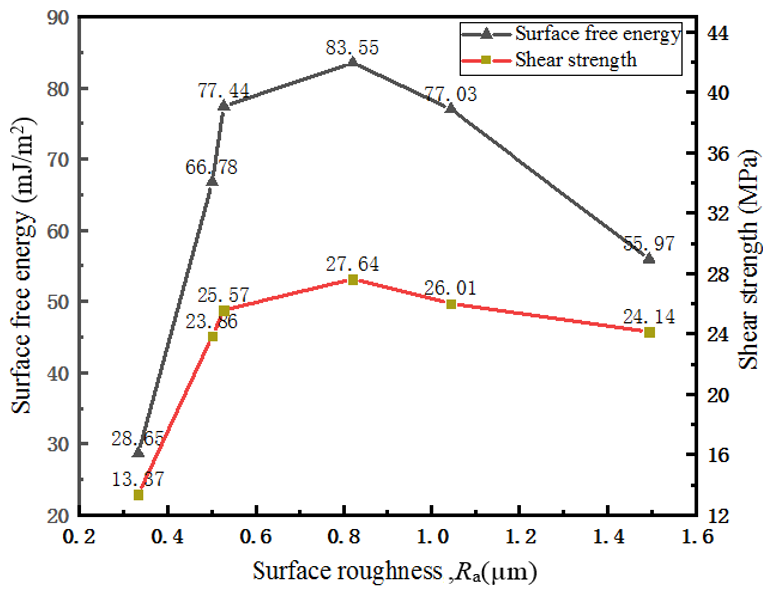
Figure 9. The relationships between R a, surface free energy, and shear strength.